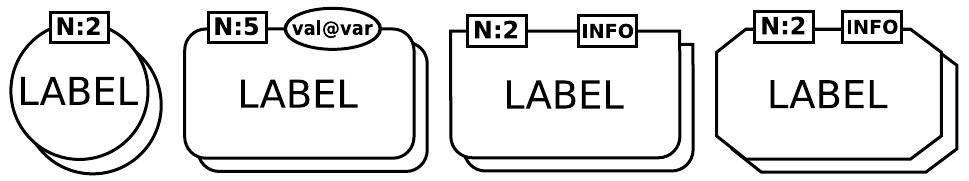
Figure 2.12: The Process Description glyph for multimer with an additional unit of infor- mation containing the